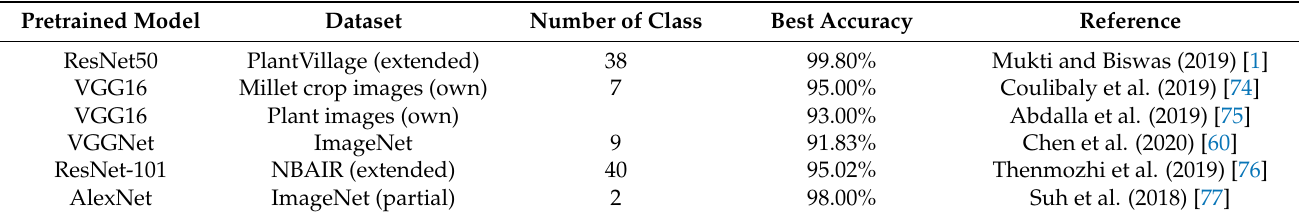
Table 3. Studies on transfer learning technology applied to the identification task.